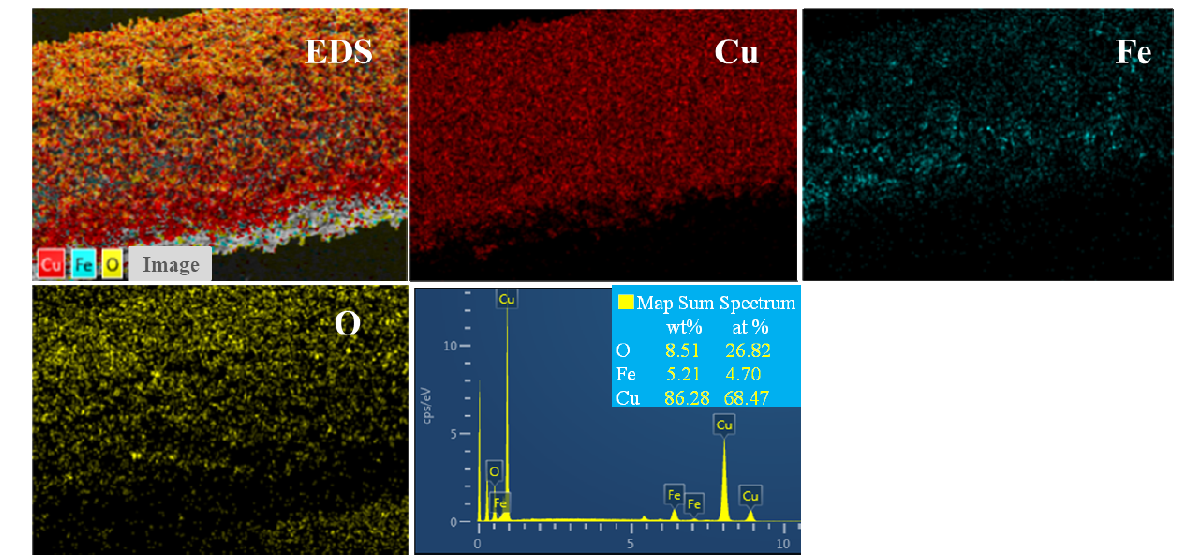
Figure 3. SEM-EDS of Cu-SSE before the EF reaction (300×).